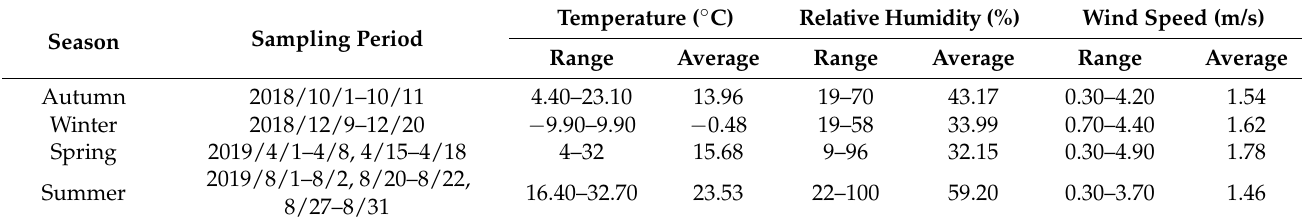
Table A2. Meteorological conditions during the sampling periods in